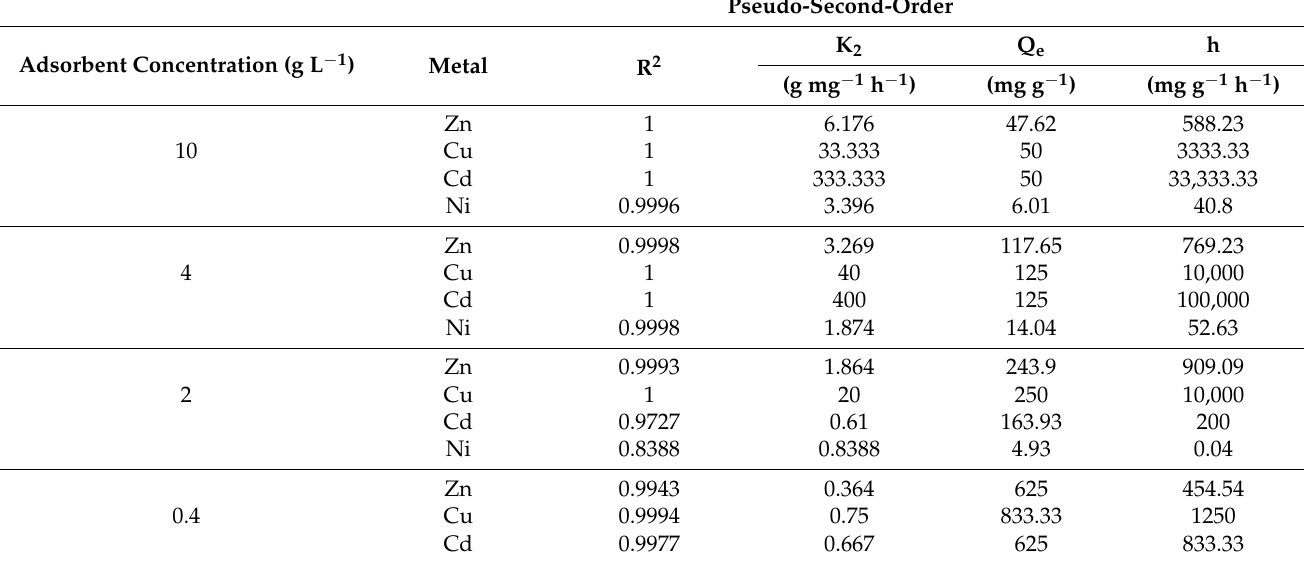
Table 6. Kinetic parameters.